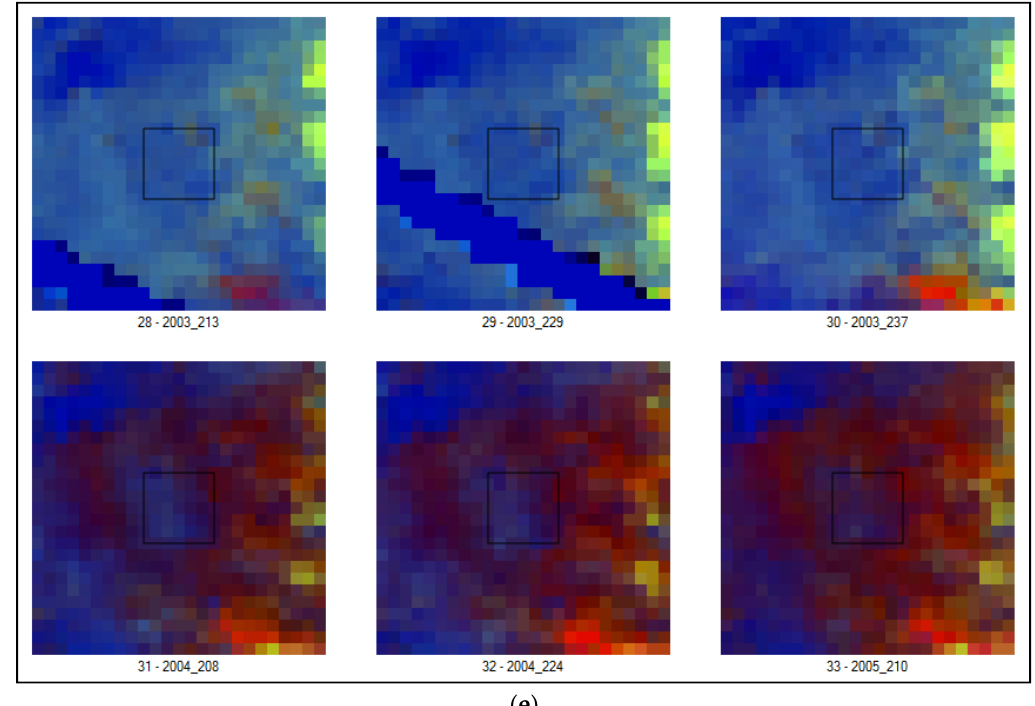
Figure A3. A 2004 Fire patch generated by LandTrendr at Mount Rainier National Park. ( a ) Photo collected during field validation. Photo credit: NPS/ Natalya Antonova (2016). ( b ) Pre-disturbance 2003 aerial photo as viewed in Google Earth™. ( c ) Post-disturbance 2006 aerial photo as viewed in Google Earth™. ( d ) TimeSync spectral trajectory of thirty six pixels around patch centroid. ( e ) Part of the series of tasseled-cap image chips covering pre- and post-disturbance years as viewed in TimeSync. Dark blue streaks in ( e ) correspond to Landsat 7 missing scan lines.